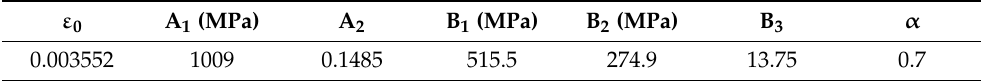
Table 1. Parameters of the combined model for 3.0 wt% silicon steel.